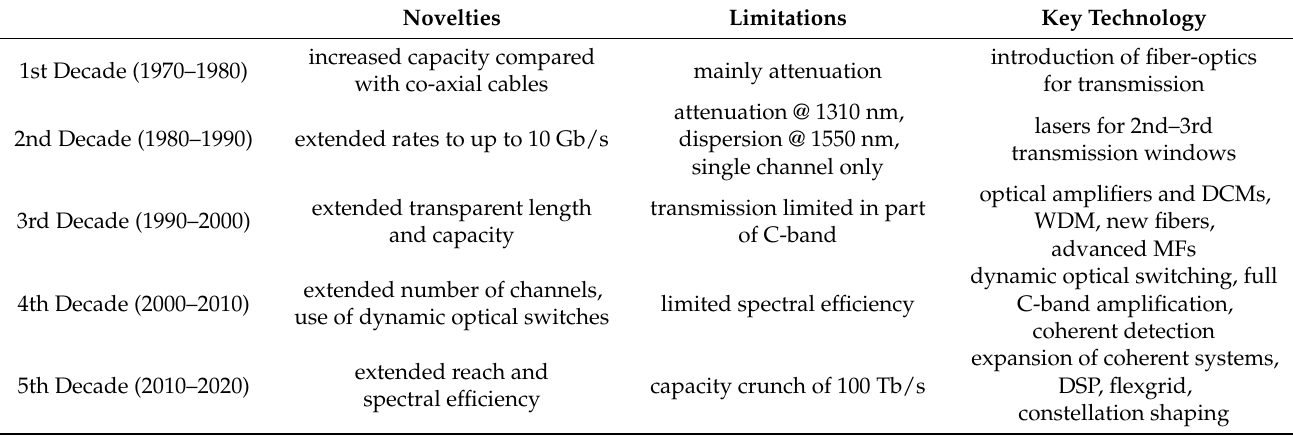
Table 10. Summary of the key advances and limitations in the physical layer for each